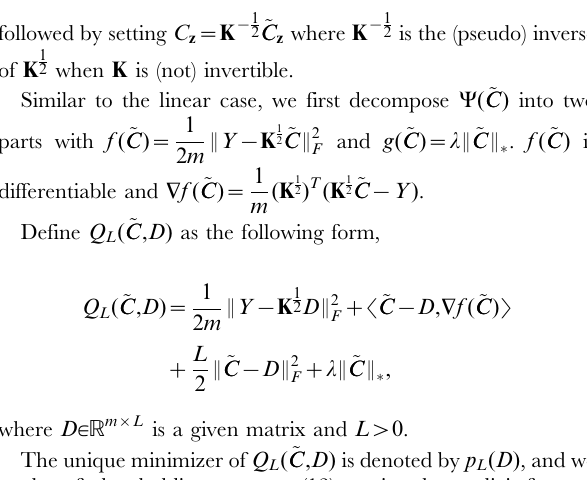
Algorithm 2. Nesterov’s algorithm for solving (10)